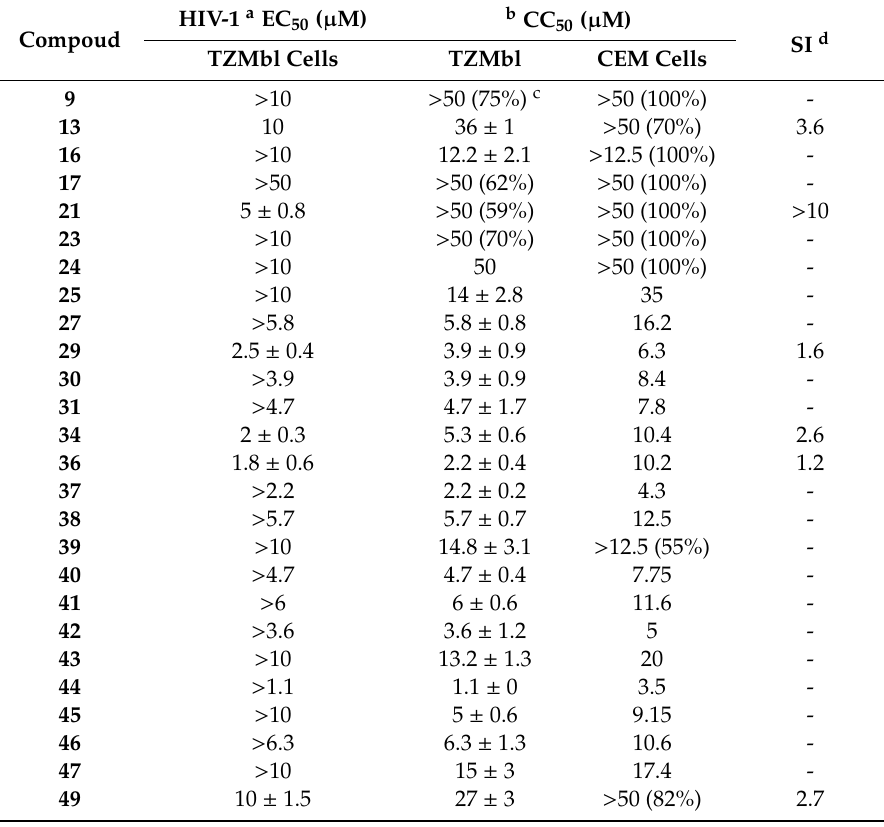
Table 2. Biological e ff ects of derivatives on HIV-1